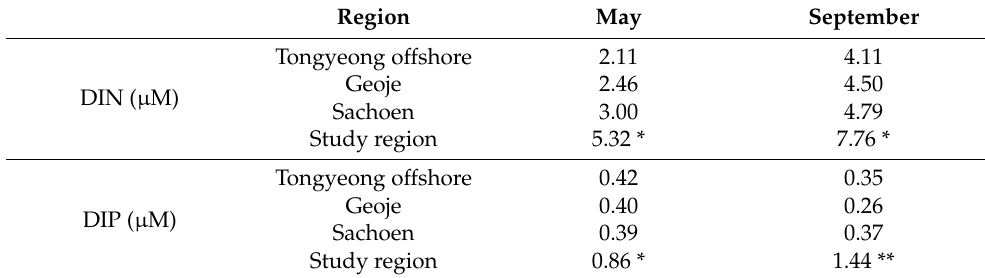
Table 5. Comparison of dissolved inorganic nutrient levels around the southern coastal waters of Korea. Asterisk indicates a significantly different level from other regions (* p < 0.05, ** p < 0.01; Kruskal–Wallis test). DIN, dissolved inorganic nitrogen; DIP, dissolved inorganic